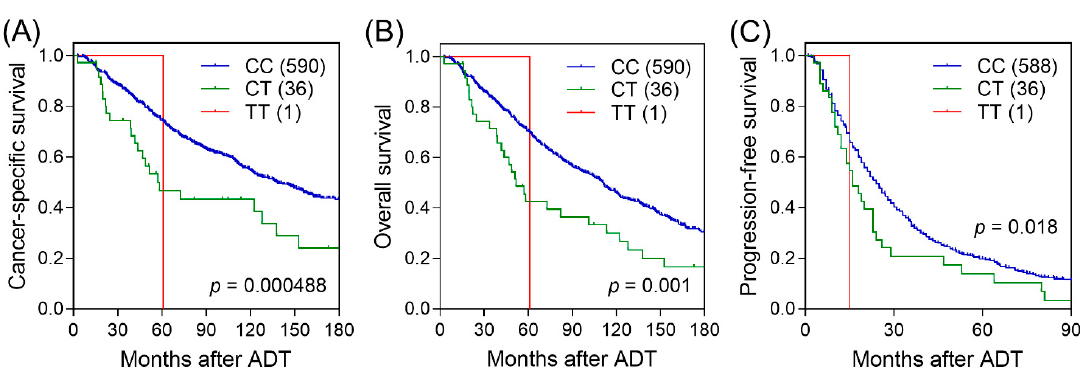
Figure 2. Kaplan–Meier curves estimating the associations of NRG1 rs144160282 with ( A ) cancer-specific survival (CSS), ( B ) overall survival (OS), and ( C ) progression-free survival (PFS) in patients with prostate cancer under ADT. Values in brackets represent the number of patients.